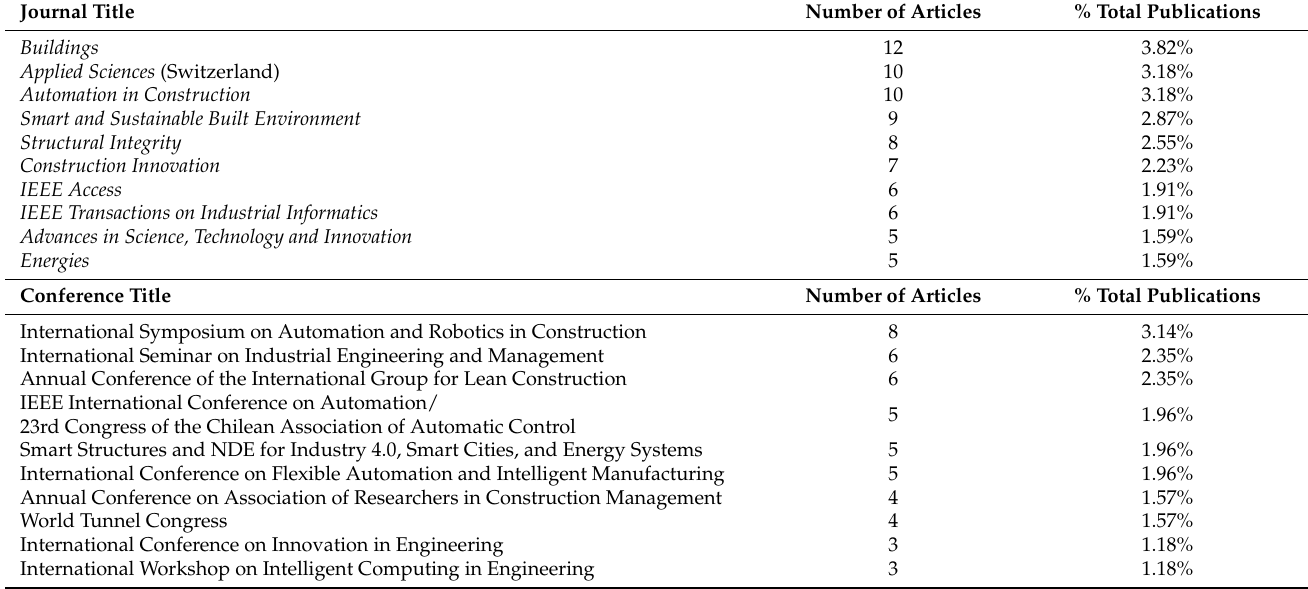
Table 7. List of the top 10 academic journals and conference proceedings from January 2006 to March 2022 covering publications related to Industry 4.0 in